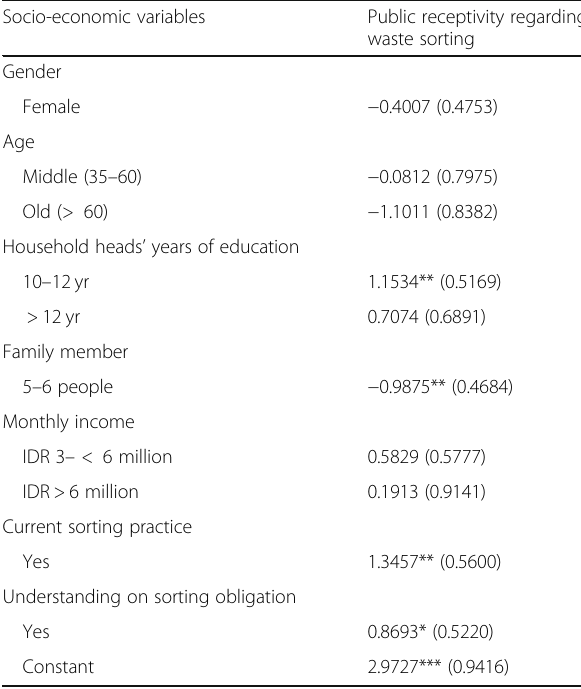
Table 7 Results from the binary logistic regression on public receptivity regarding waste sorting Socio-economic